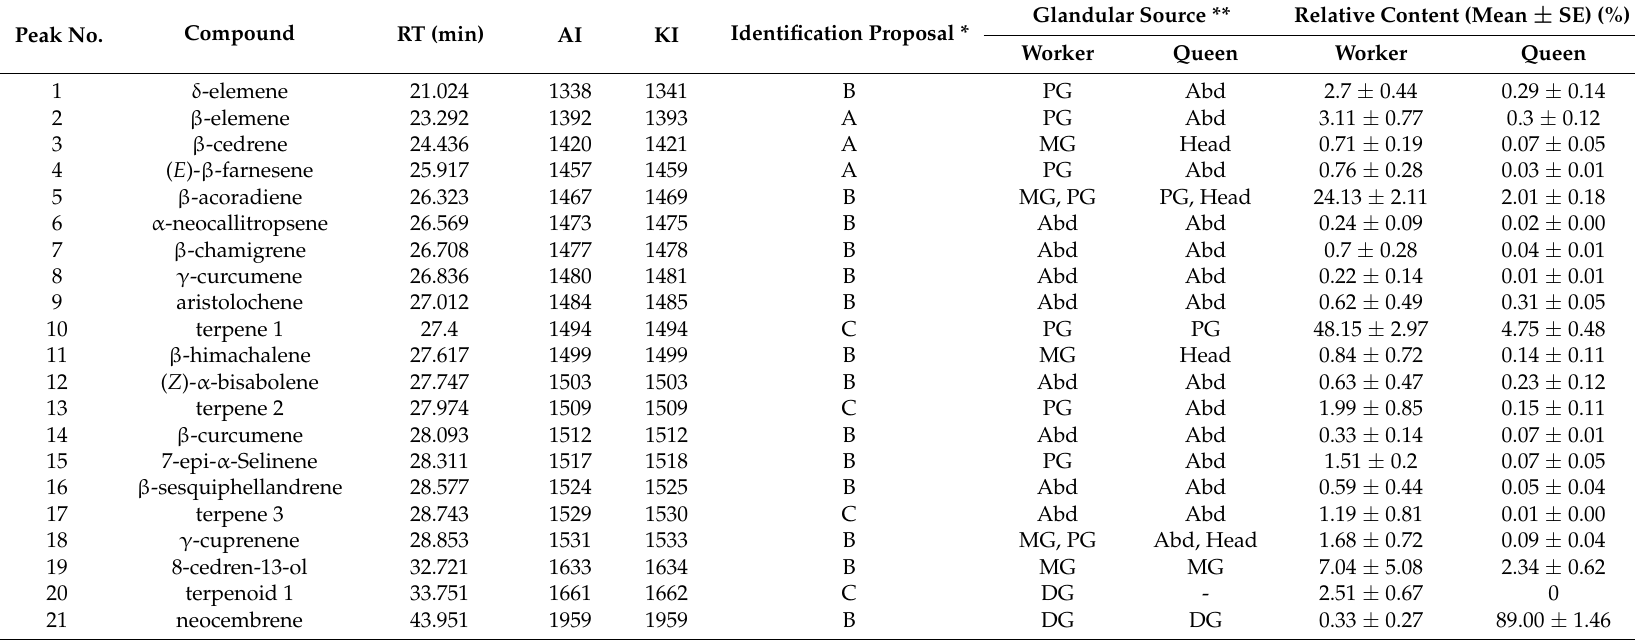
Table 1. Volatile terpenes and terpenoids from workers and queens of Monomorium chinense